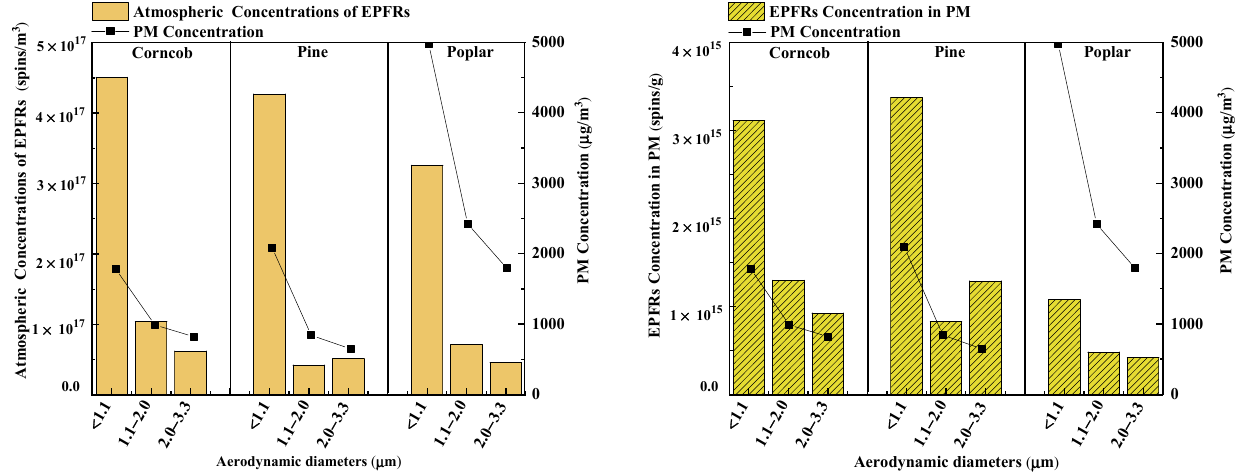
Table 2. Size distribution of EPFRs and PM in simulated biomass combustion particles from Xuanwei (%). Sample Groups